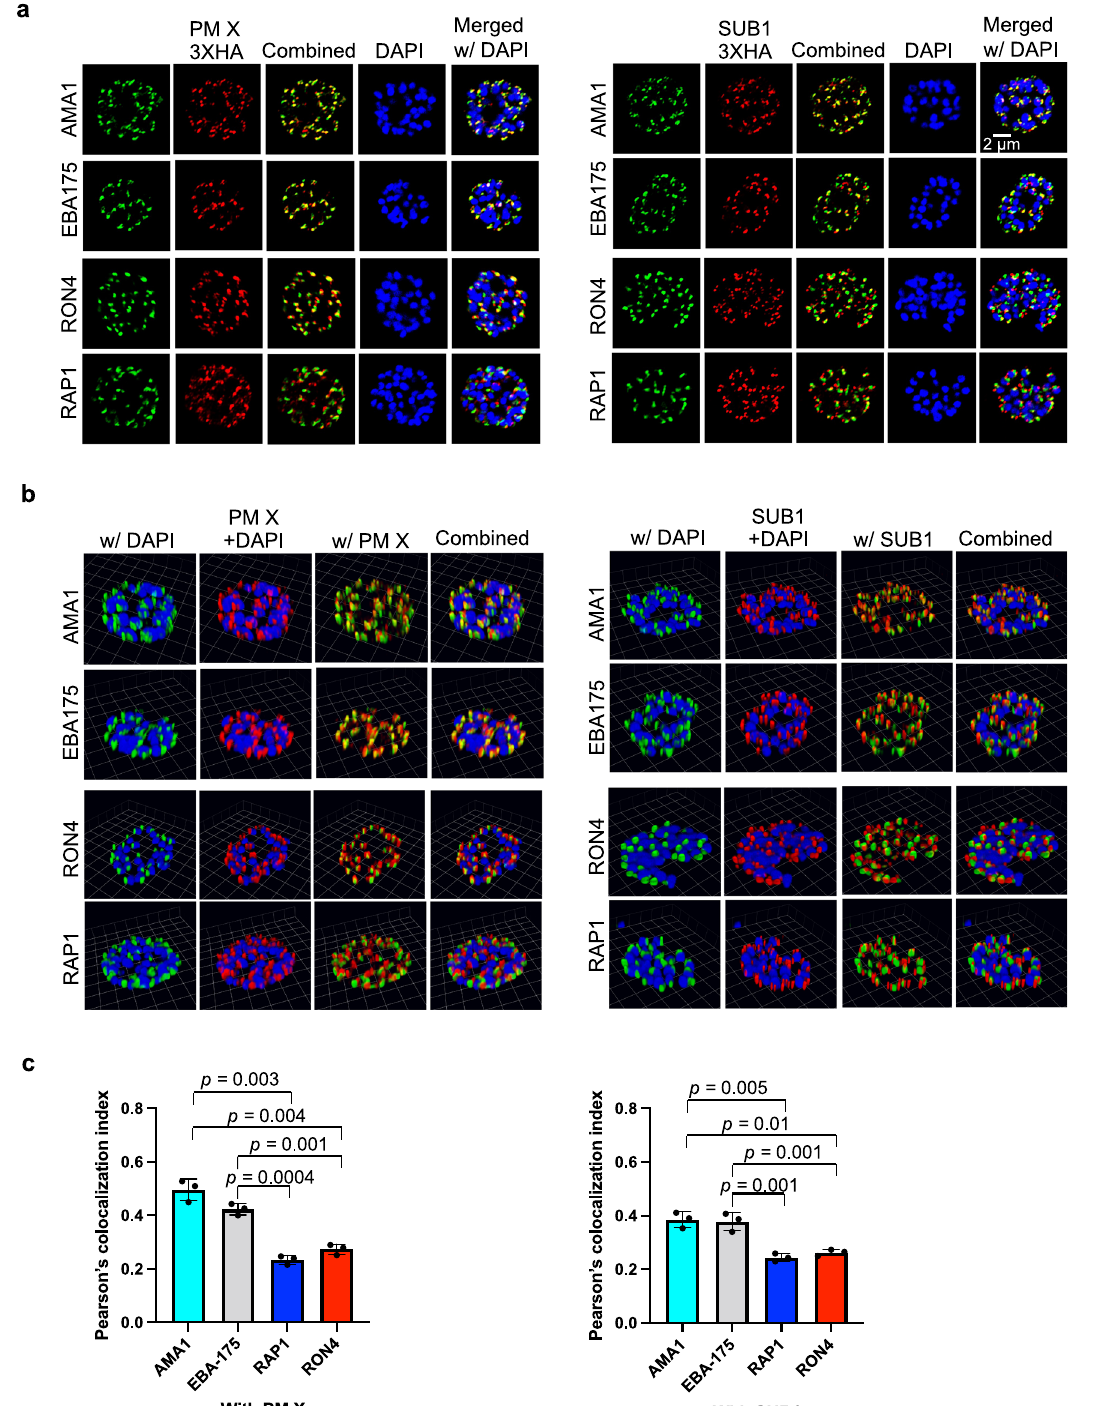
Fig. 8 | PM X and SUB1 signals overlap signi fi cantly more with microneme markers (AMA1 and EBA175) than with rhoptry neck (RON4) or bulb (RAP1) markers in terminal schizonts. Synchronized, C1-treated 48 – 50h schizonts expressing either PM X-3xHA or SUB1-3xHA were fi xed in paraformaldehyde and processed for immuno fl uorescence assays. After labeling with the indicated anti- bodies, samples were visualized by confocal Airyscan microscopy. Images in a are